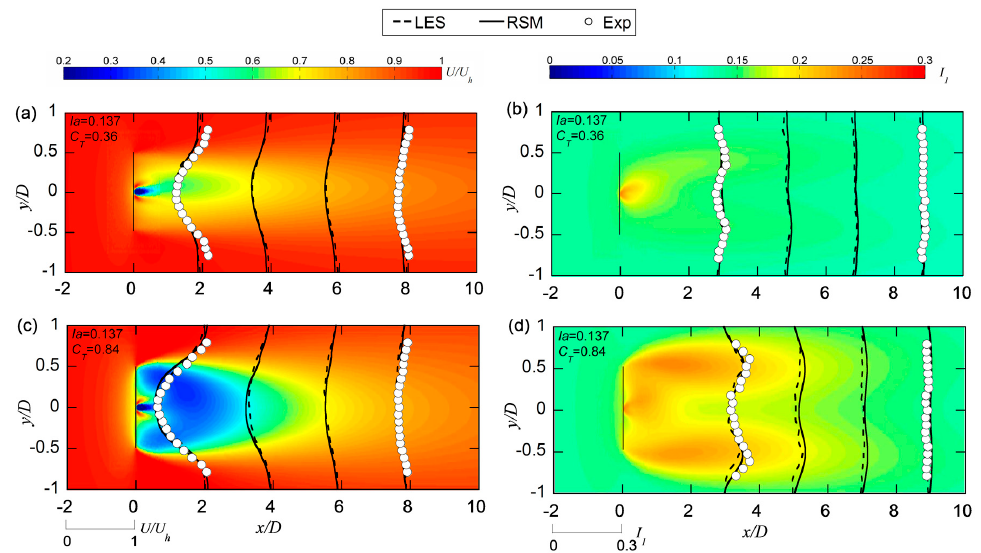
Figure 5. Wake characteristics in the horizontal x - y plane at hub height under non-yawed conditions: ( a , c ) for normalized mean velocity; ( b , d ) for turbulence intensity.